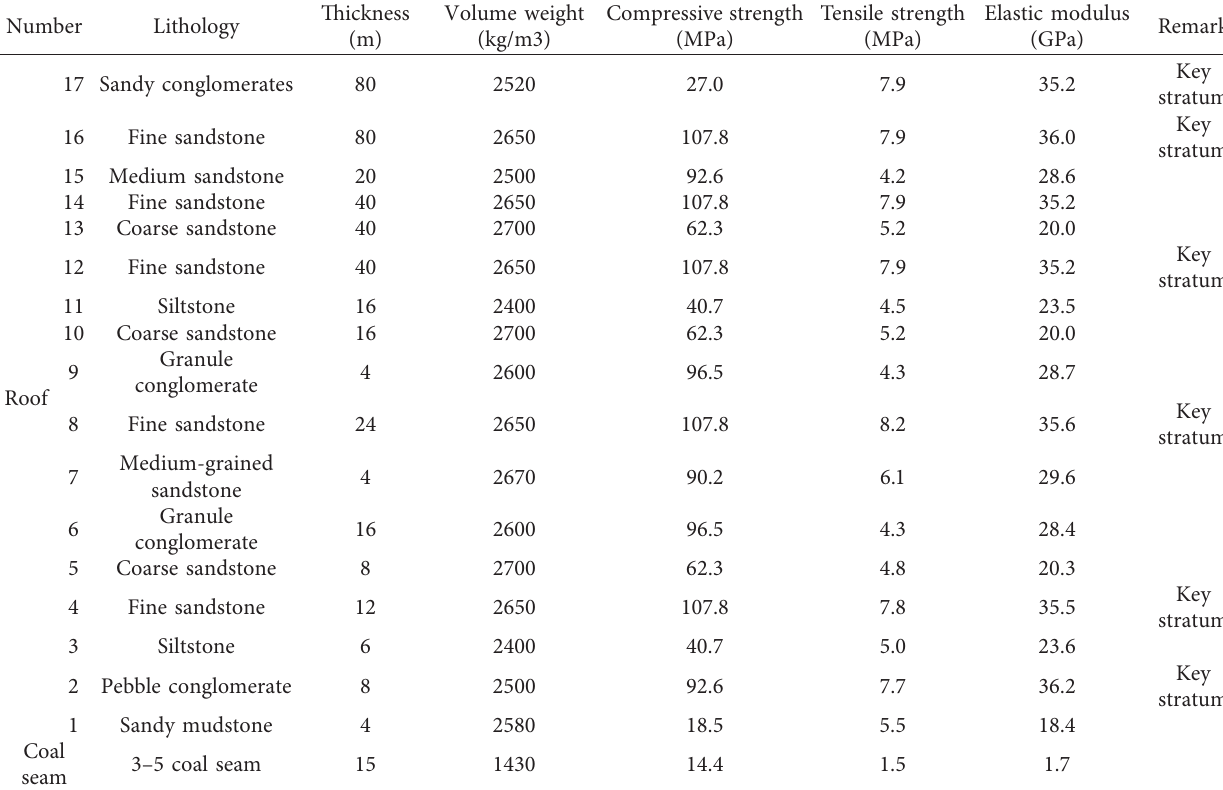
Table 1: Physical properties of coal and roof in No. 8100 longwall face.